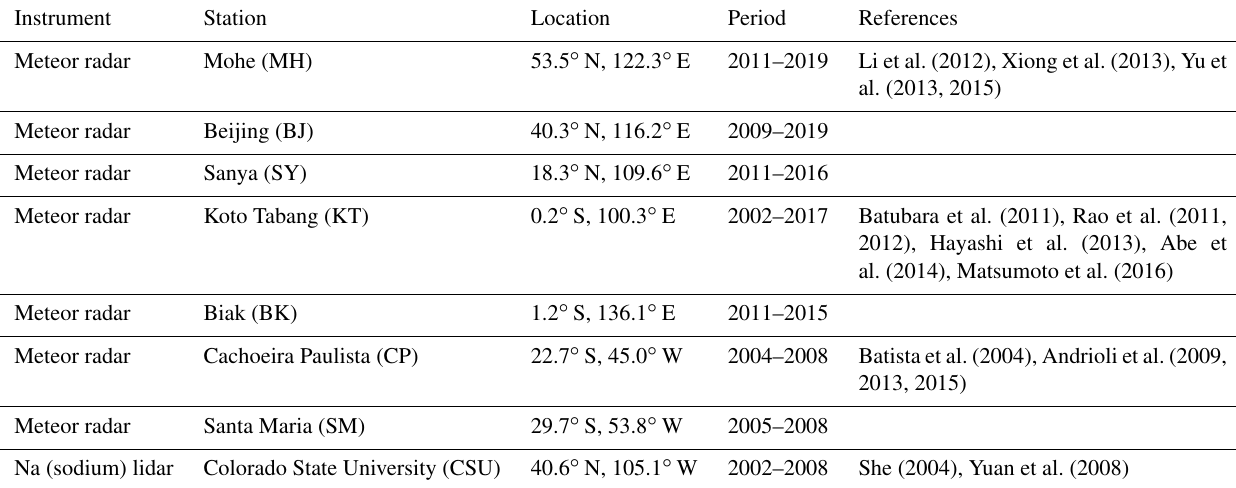
Table 1. Locations of radar and lidar and their data